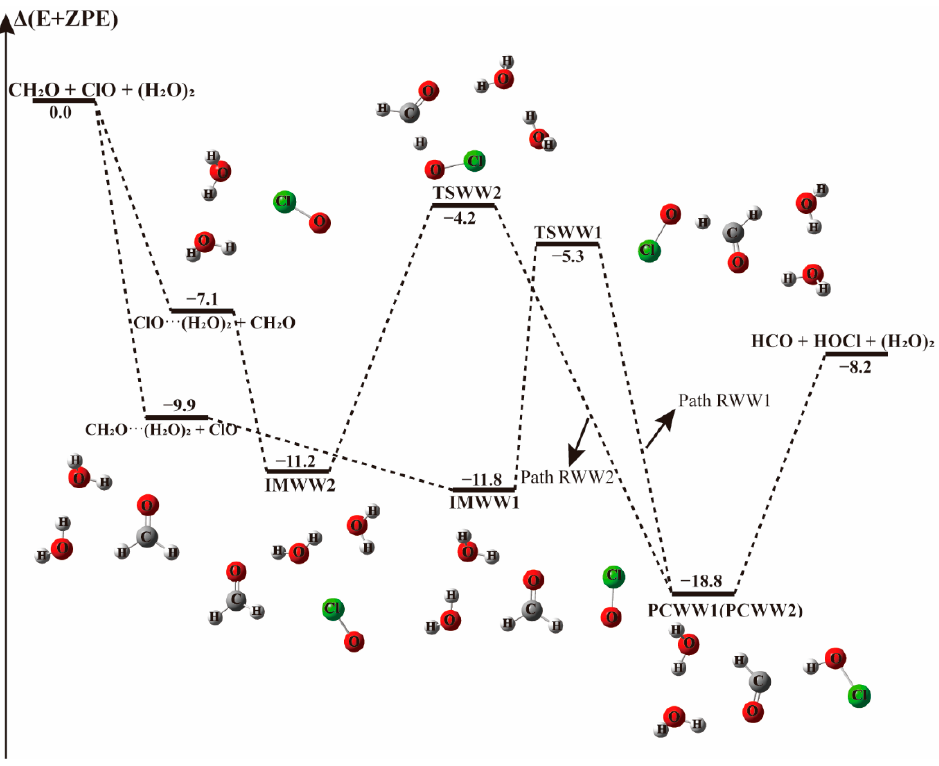
Figure 6. The energy profile of the CH 2 O + ClO water-involved reaction occurring through CH 2 O···(H 2 O) 2 + ClO and ClO···(H 2 O) 2 + CH 2 O pathways. Energies (in kcal mol − 1 ) are calculated at the CCSD(T)/aug-cc-pVTZ//B3LYP-D3/aug-cc-pVTZ level.